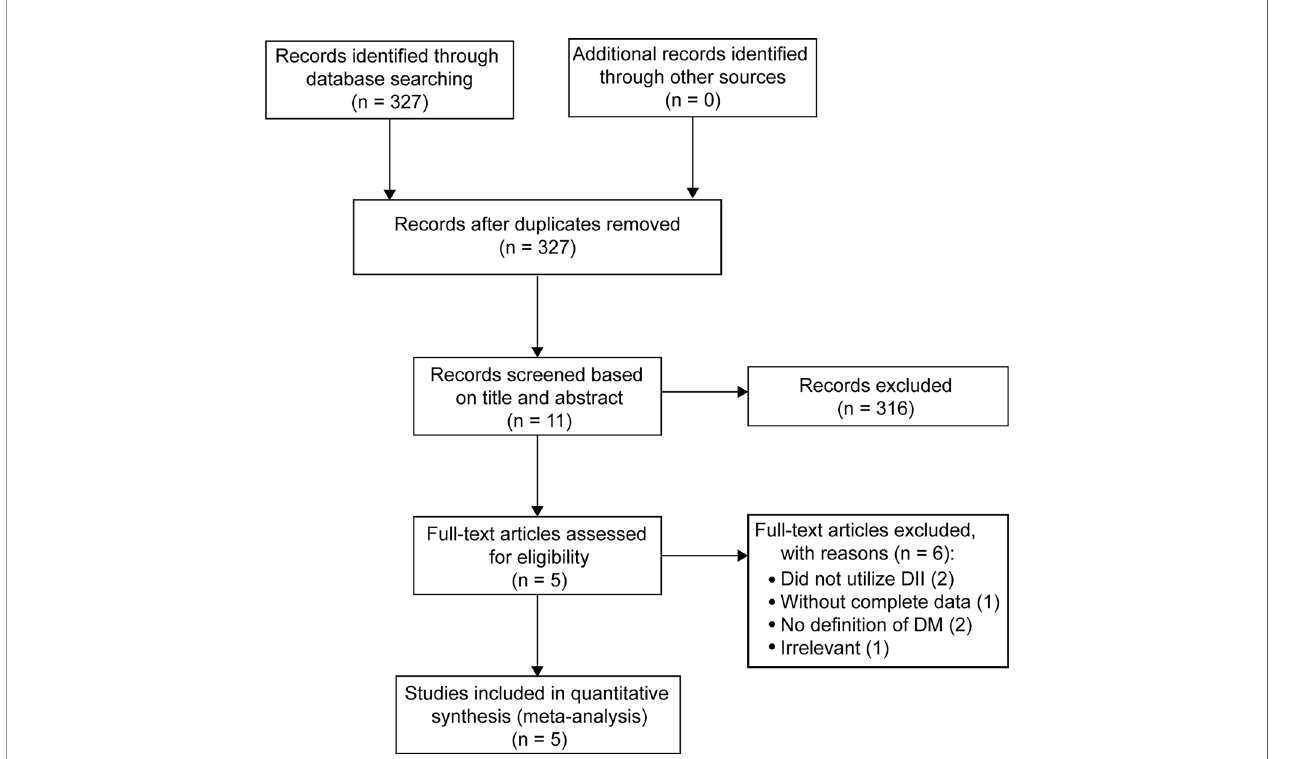
FIGURE 1 | PRISMA fl owchart describing the search and selection of relevant